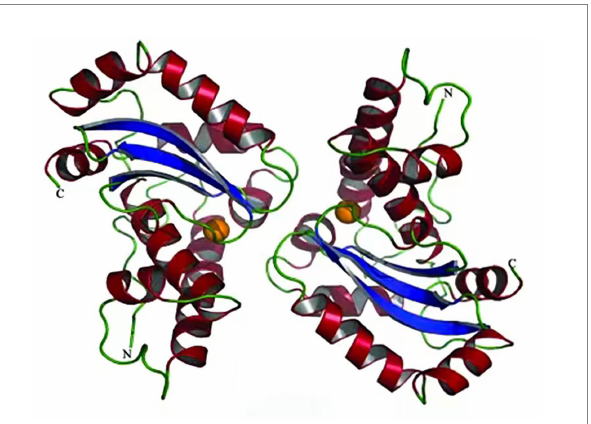
(Figure 4). The enzyme has maximum activity at 15 ° C and pH 8.0 and is heavily dependent on Mg 2+ . Further analysis of its amino acid sequence and structure found that amino acids without five- membered ring side chain such as cysteine and glutamic acid, and a reduction in the number of disulfide bonds, in its catalytic domain are more conducive to maintaining the enzyme’s structural flexibility (Albino et al., 2014).